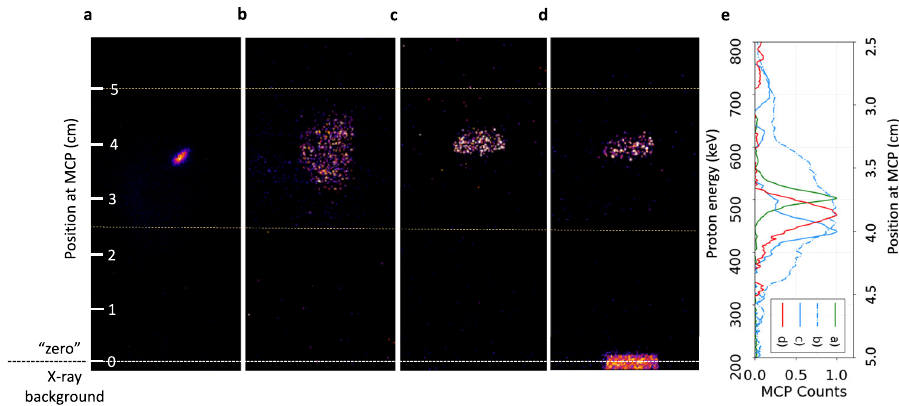
Fig. 8 Example of raw data acquired with the MCP detector coupled to the magnet spectrometer. The total height of the MCP phosphor screen is 7.8 cm. Each image shows the acquisition from an individual shot, with a voltage of 5000 V and a gain of 20. The “ zero" point that corresponds to the “ non de fl ected" reference position of the proton beam is found by locating the center of the X-ray background along the vertical direction as indicated by the dashed white line. a Selected proton beam signal obtained with a 20 μ m entrance slit and a 20 μ m exit pinhole on the energy selector. b Selected proton beam signal after passing through the solid carbon foil. c Selected proton beam signal after passing through the solid carbon foil with a 1 mm horizontal slit inserted in front of the spectrometer entrance. d Selected proton beam signal after passing through the WDM sample with a 1 mm horizontal slit inserted in front of the spectrometer. The X-ray background is produced by the heater beam interaction with the target. e Vertical lineouts of the images ( a ), ( b ), ( c ), ( d ) as a function of the position on the MCP screen and of the corresponding energy calculated using the energy dispersion by the magnetic fi each point of the considered pro fi le. The free electron density is calculated as n e = 6 n 6 + 5 n 5 + 4 n 4 + 3 n 3 + 2 n 2 + n 1 . The mean plasma ionization degree Z * is then determined from the relation n e = Z * n i . Here, n i = ρ N A / A t is the total ion density, where A t = 12 is the molar mass of carbon and N A is the Avogadro number. The free-electron stopping power is calculated using the density n e with the Zimmerman, Li-Petrasso and T-Matrix models. The bound-electron stopping